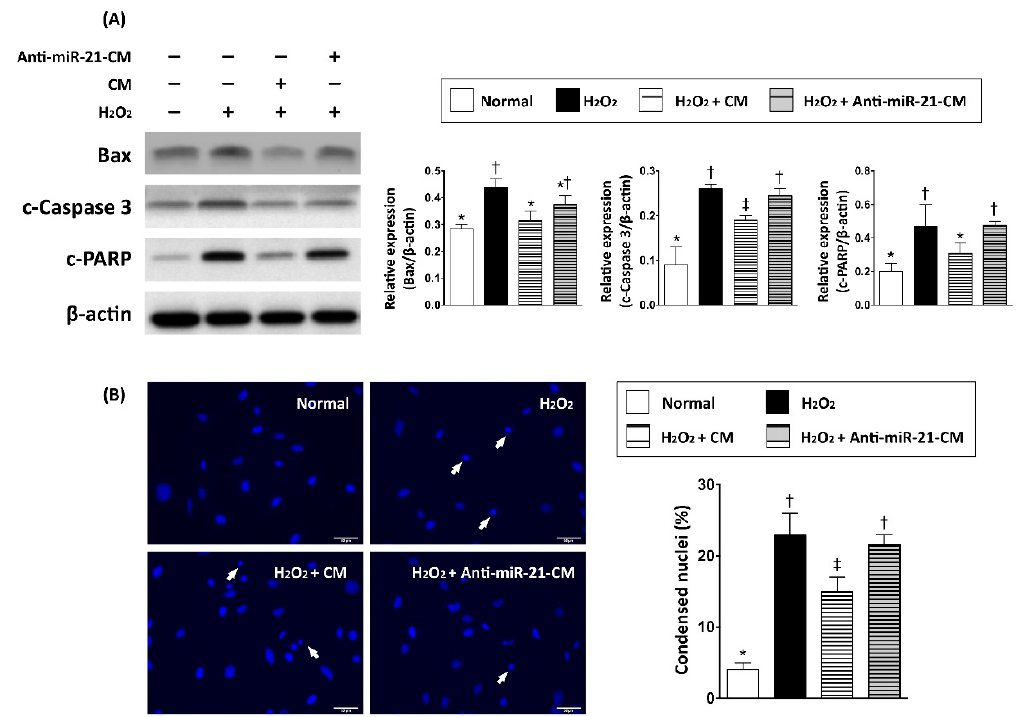
Figure 3. Inhibition of miR-21 reduced the protective e ff ect of cardiomyocyte-derived conditioned medium on cardiomyocytes against oxidative stress. ( A ) Western blots to determine the expression levels of apoptosis-associated proteins, including Bax, cleaved caspase 3 (c-Caspase 3), and cleaved Poly (ADP-ribose) polymerase (c-PAPR), in neonatal cardiomyocytes treated with hydrogen peroxide (50 µ M of H 2 O 2 ) and cardiomyocyte-derived conditioned medium. ( B ) Nuclear staining with DAPI to observe the condensed nuclei in apoptotic cells. CM, conditioned medium derived from OGD-treated cardiomyocyte. Anti-miR-21-CM, conditioned medium derived from cardiomyocyte pre-transfected with anti-miR-21 (20 nM). Groups with di ff erent symbols (*, † , ‡ ), p < 0.05. n = 6 for each group.